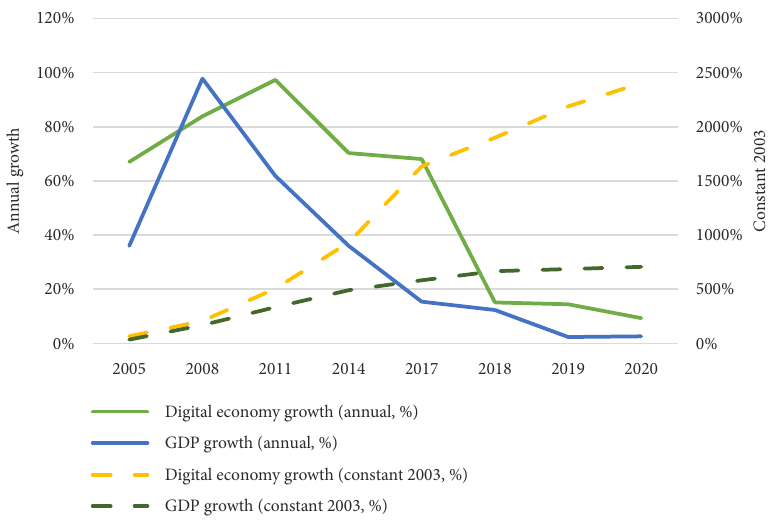
Figure 2. Overall scale and proportion of Chinese digital economy in GDP in